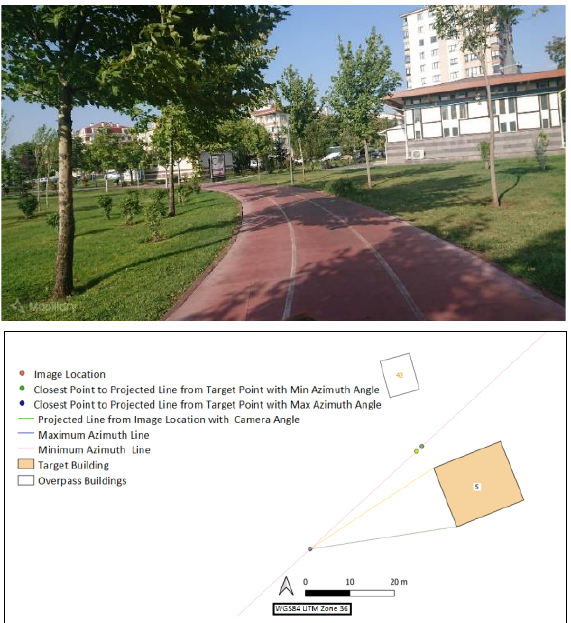
Figure 6. The map of image location relative to the target